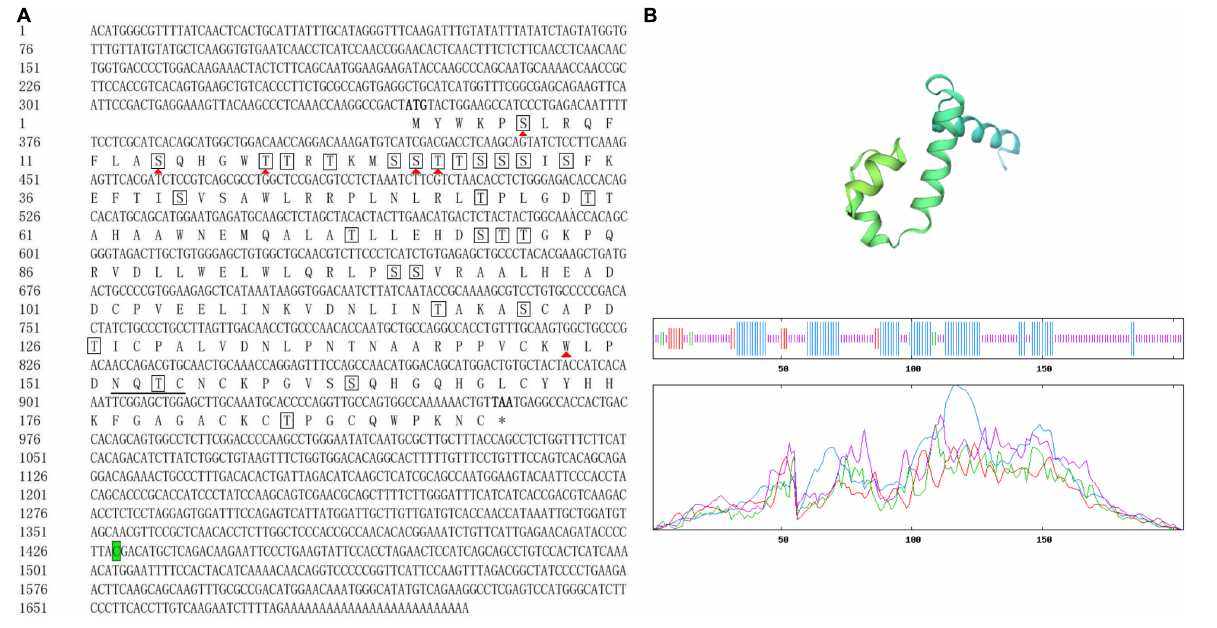
Frontiers in Marine Science |